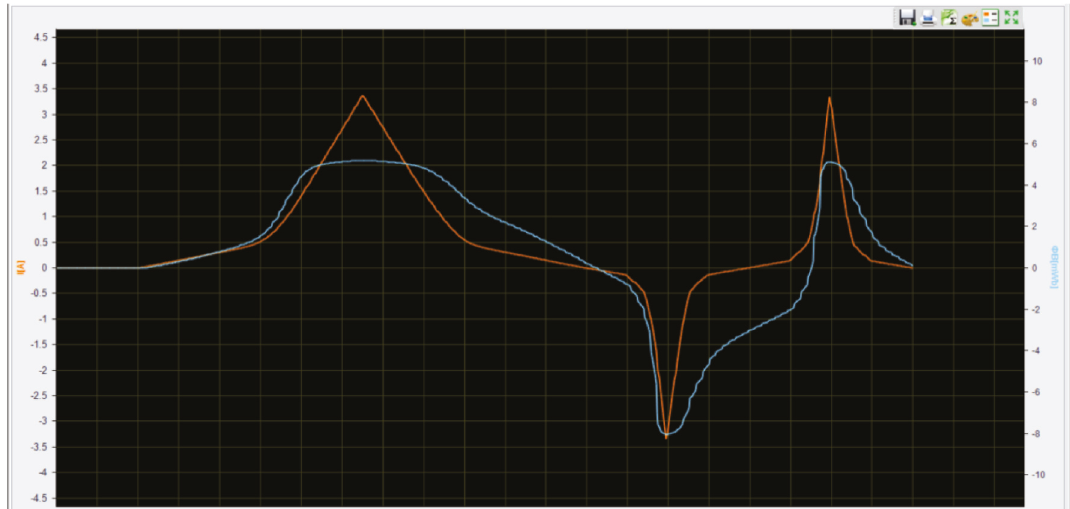
Figure 8: Waveform of excitation current-excitation magnetic field.